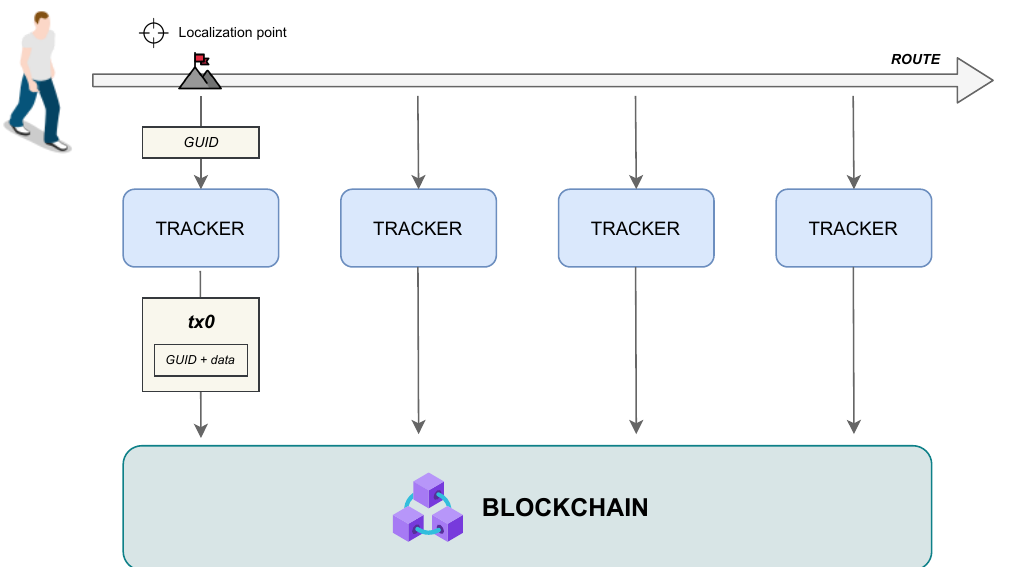
Figure 5. Working model of the